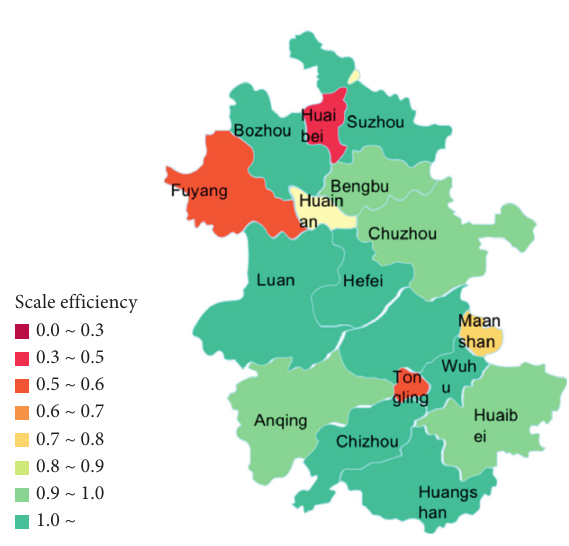
Figure 11: Scale efficiency 2019. Table 5: The Malmquist index and its decomposition of the inbound tourism efficiency in Anhui province from 2011 to 2019. EFFCH TECH PECH SECH TFP